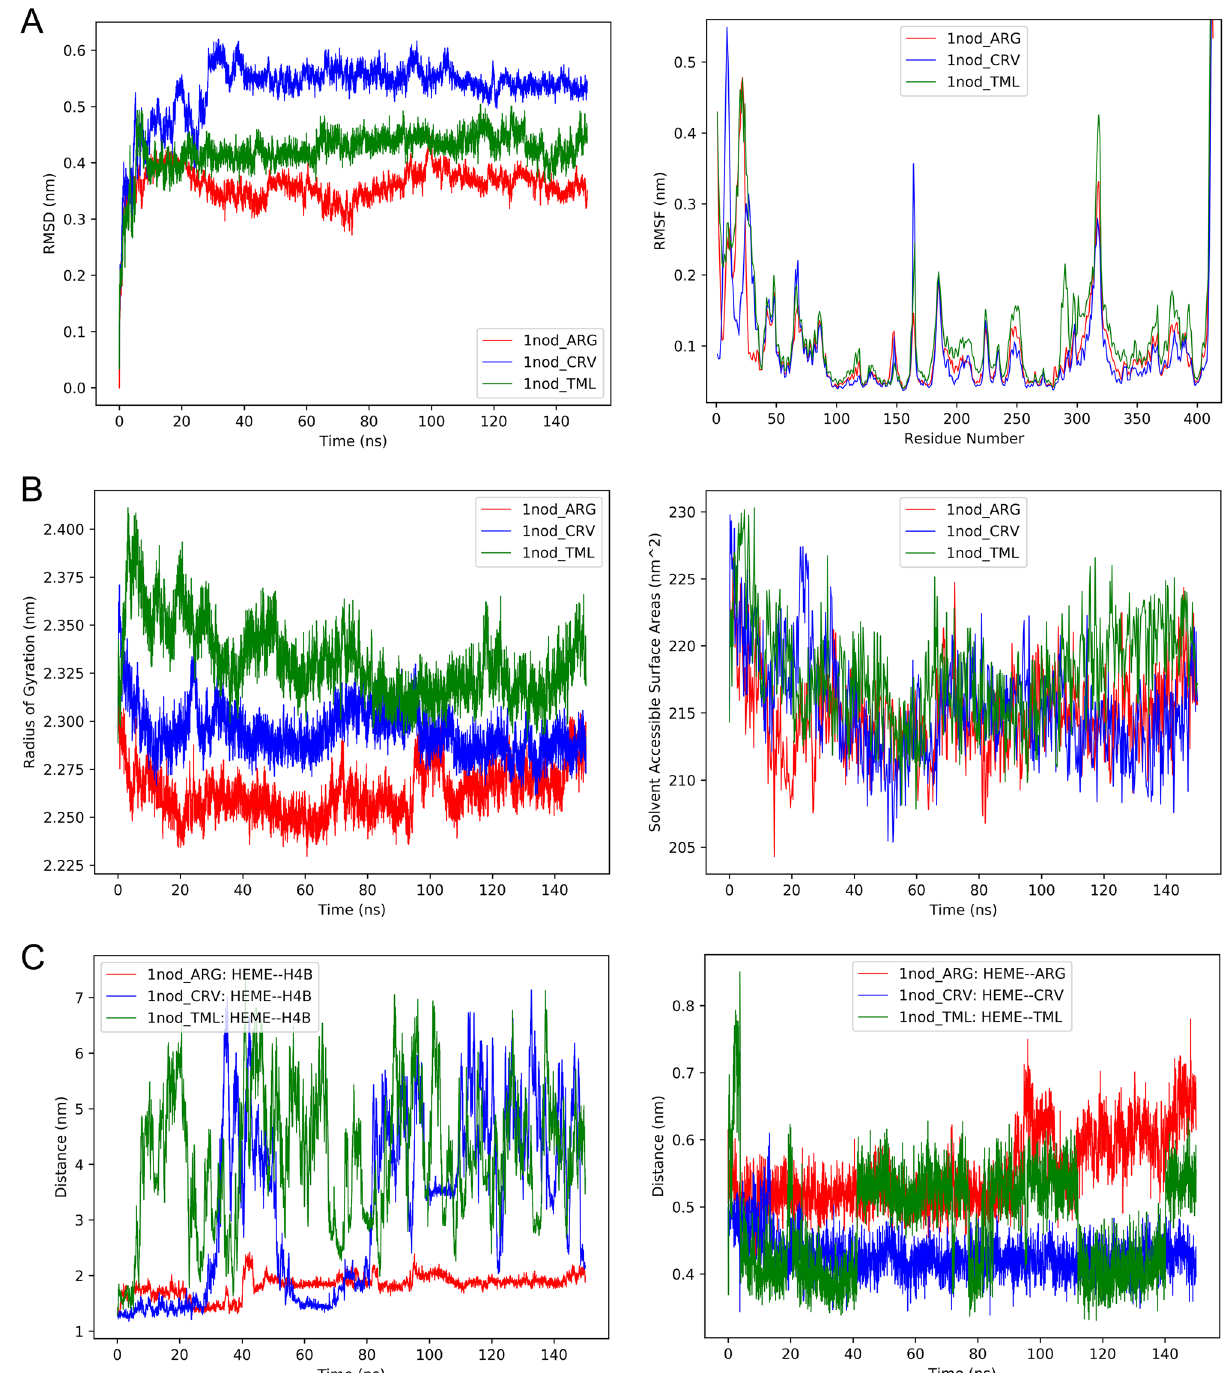
Figure 4. ( A ) Right: the RMSD and left: RMSF of C α of iNOS protein during the simulation. ( B ) Right: the radius of gyration and left: solvent accessible surface area of iNOS in case of bonding to the native ligand and the drugs. ( C ) Right: distances between the center of mass of the heme group and the enzyme’s cofactor tetrahydrobiopterin (H4B) and left: distances of the heme group with the Arg and drug molecules during the